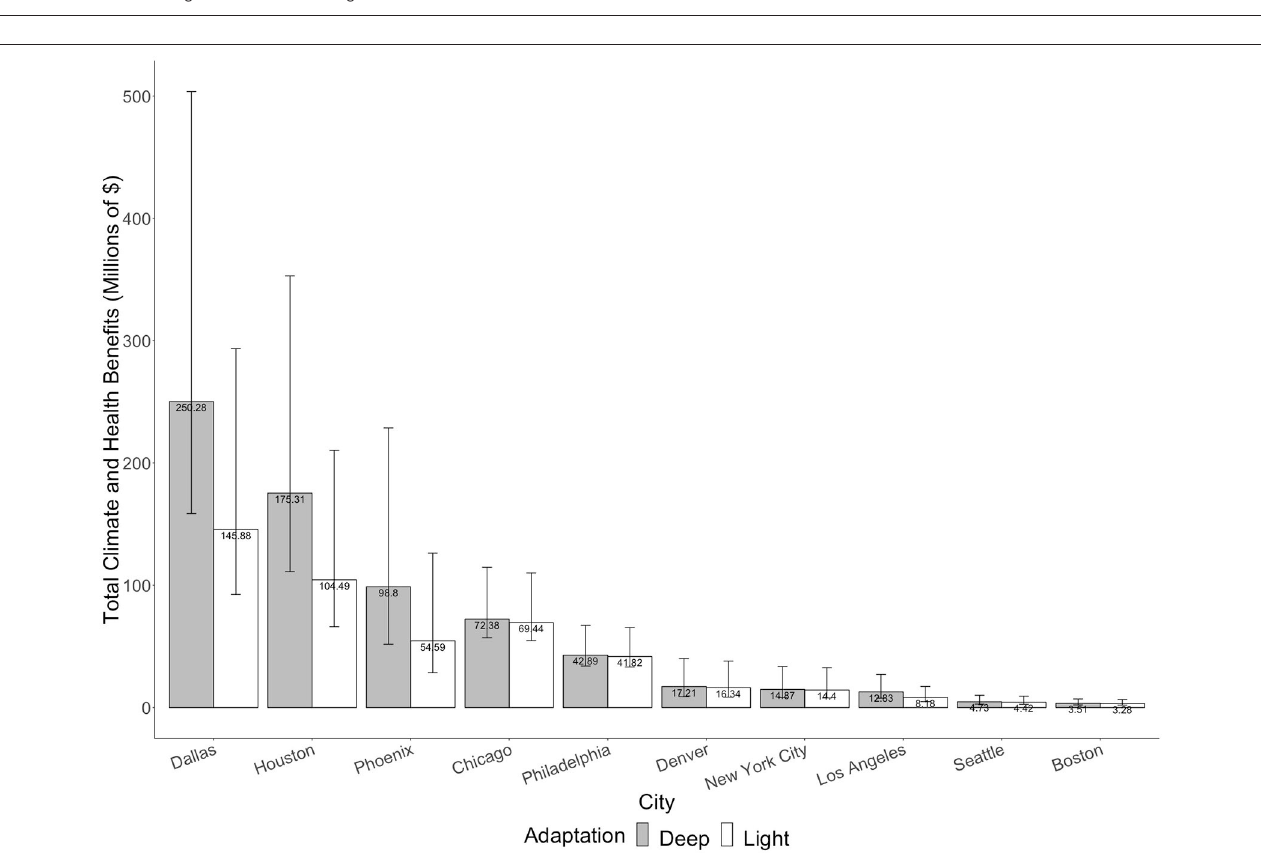
FIGURE 3 | Total estimated climate and health benefits (million 2016 USD) from light (white) or deep (gray) heat adaptation retrofits applied to detached single-family residential buildings built from 1990 to 2010. Error bars indicate low- and high-range estimates.